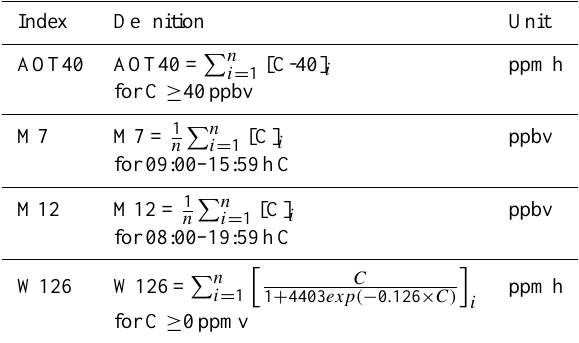
Table 1. Definitions of the ozone exposure indices used in this study. n is the number of hours in the growing season, C is the hourly ozone concentration and i is the hour